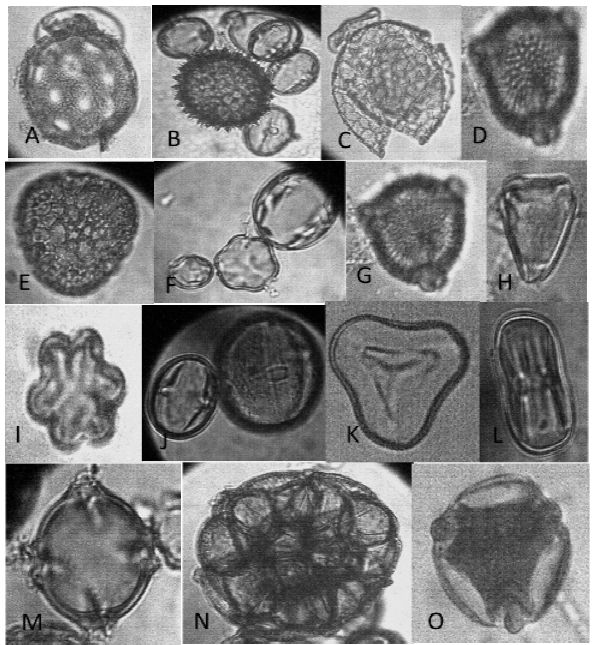
Fig. 2. A - Amaranthus sp., B - Asteraceae surrounded by five Mussaenda polita pollen; C - Bombax sp . , D – Hippocratea sp., E - Ceiba pentandra , F - Combretum sp. with Mussaenda , G- Hyppocratea , H- Syzygium guineensis, I - Combretum sp., J - Large grain: Grewia sp with Mussaenda sp. K- Elaeis guineensis , L - Sapotaceae , M – Mussaenda polita , N- Parkia clappertoniana , O - Senna sp.